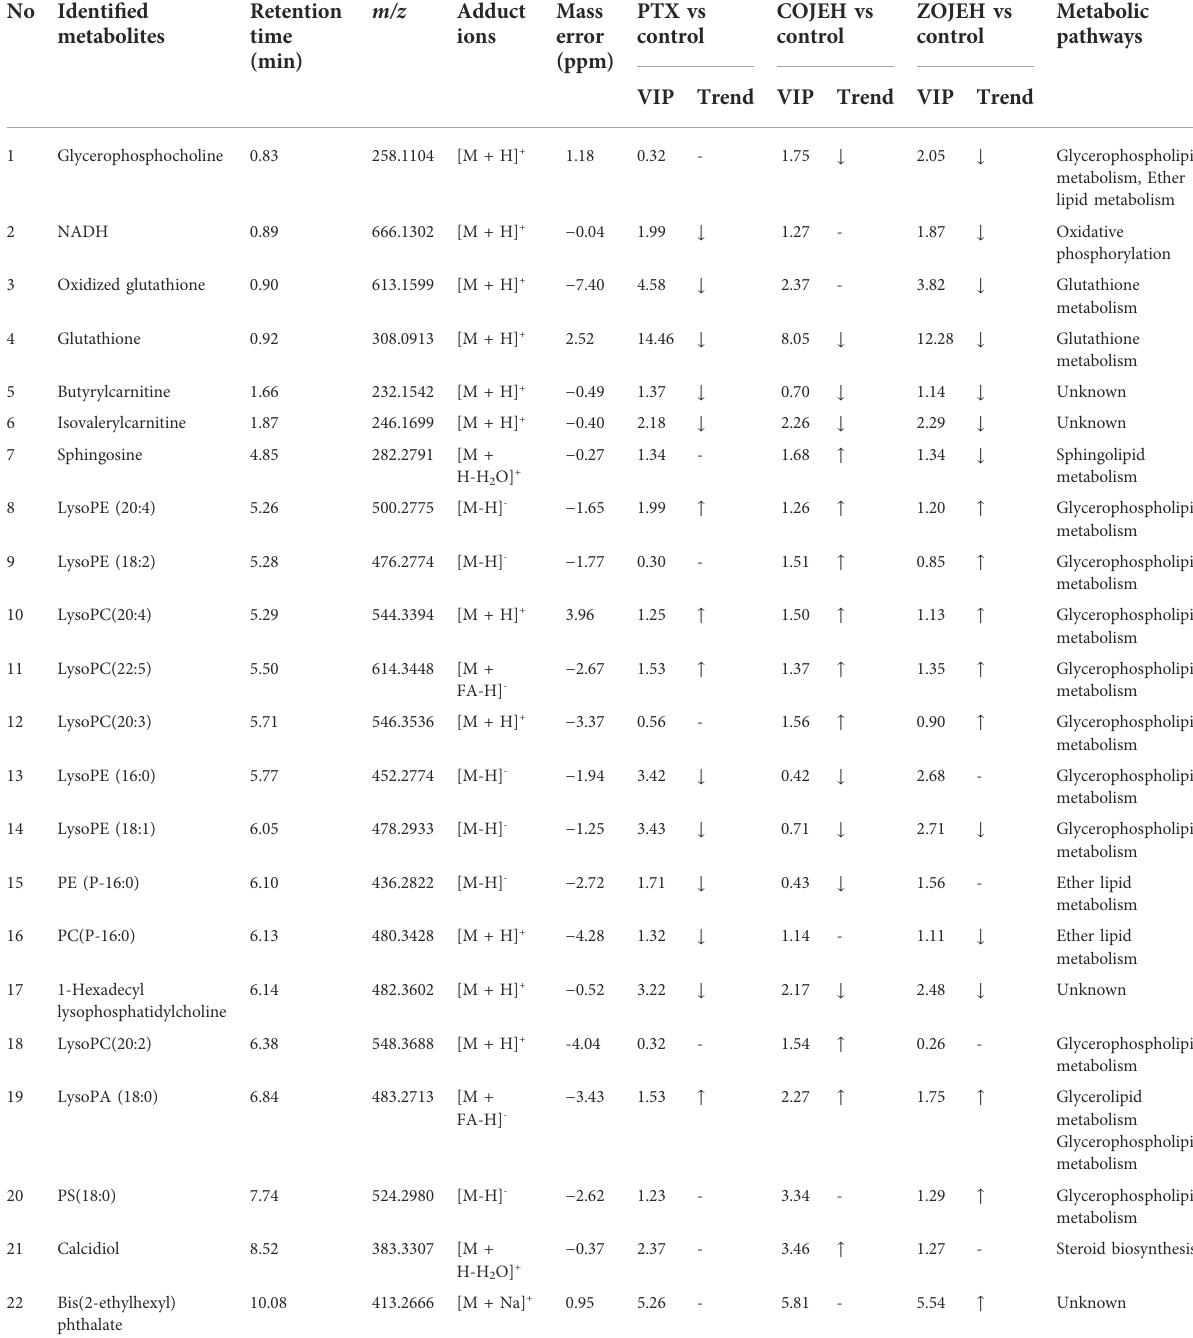
TABLE 2 Potential biomarkers associated with the anticancer effect of PTX and OJE in NCI-H1299 cells. No Identi fi ed